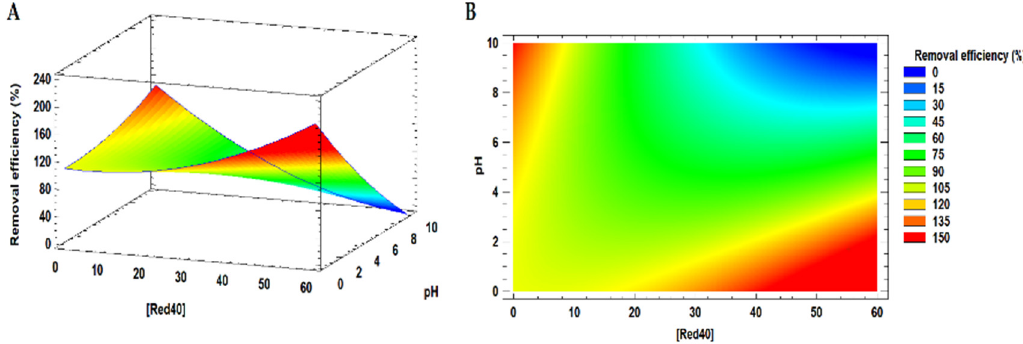
Figure 2. Three-dimensional response surface plot ( a ) and contour plot ( b ) of the removal efficiency of FD&C Red 40 dye.